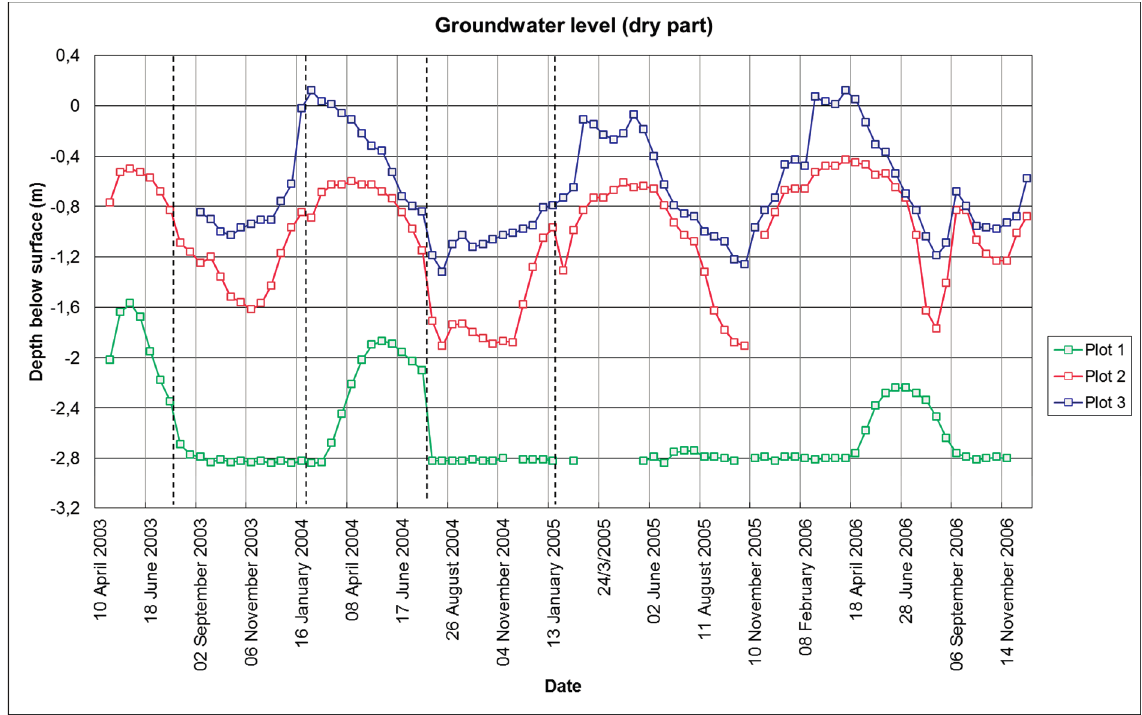
Figure 1. ( a ) Sulfate and ( b ) total S concentrations, ( c ) pH and ( d ) electrical conductivity (EC), measured in the soil profile at Plot 3 in fall 2005 and 2006 (values are averages for six replicates; error bars indicate standard deviation for six